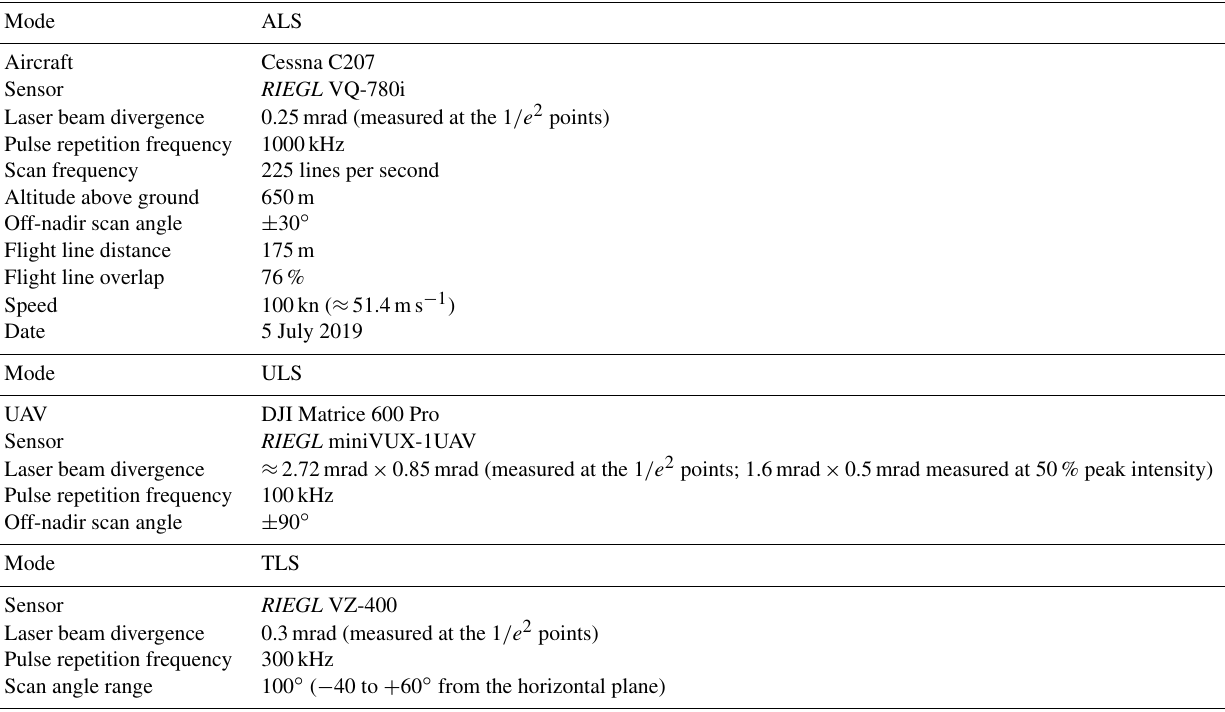
Table 1. Airborne laser scanning (ALS), UAV-borne laser scanning (ULS) and terrestrial laser scanning (TLS) sensor and acquisition pa- rameters. Sensor specifications are according to the data sheets ( RIEGL Laser Measurement Systems, 2017, 2019,